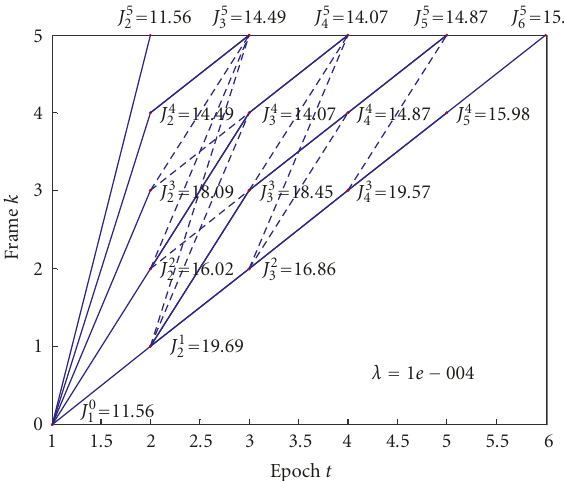
Figure 2: An example of DP trellis for the average distortion minimization